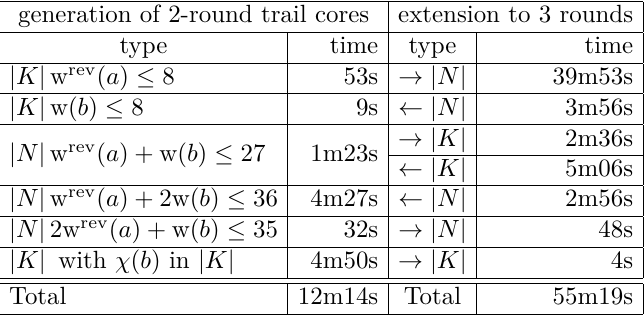
Table 11: Execution time for the generation of 3-round trail cores up to weight 36 using the new techniques presented in this work. Last line refers to the technique of